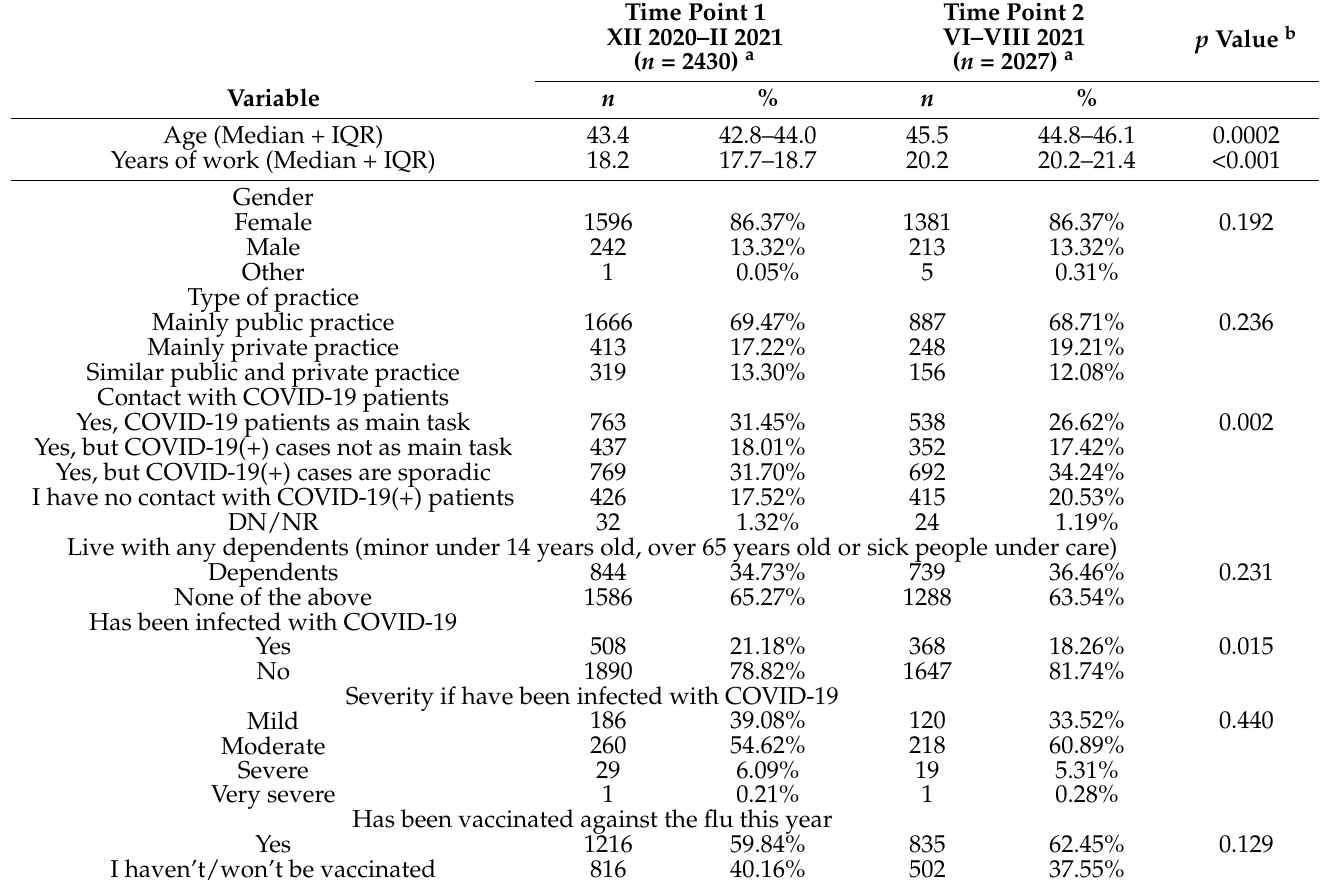
Table 1. Descriptive analysis by submission time. COVID-19 Vaccine Hesitancy Study.